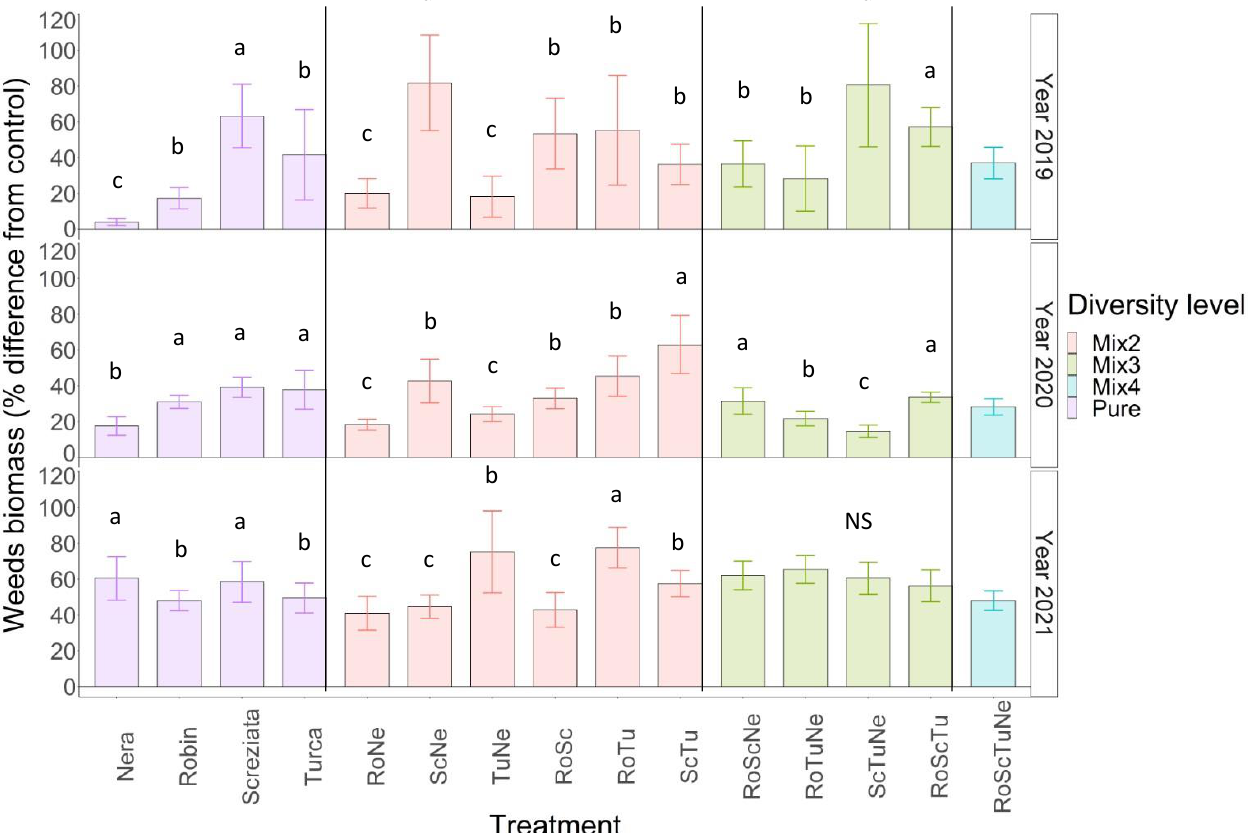
Table 2. Results of orthogonal contrasts for weed biomass for all lentil mixtures in the three experi- mental years; expressed as sensitivity ratios.